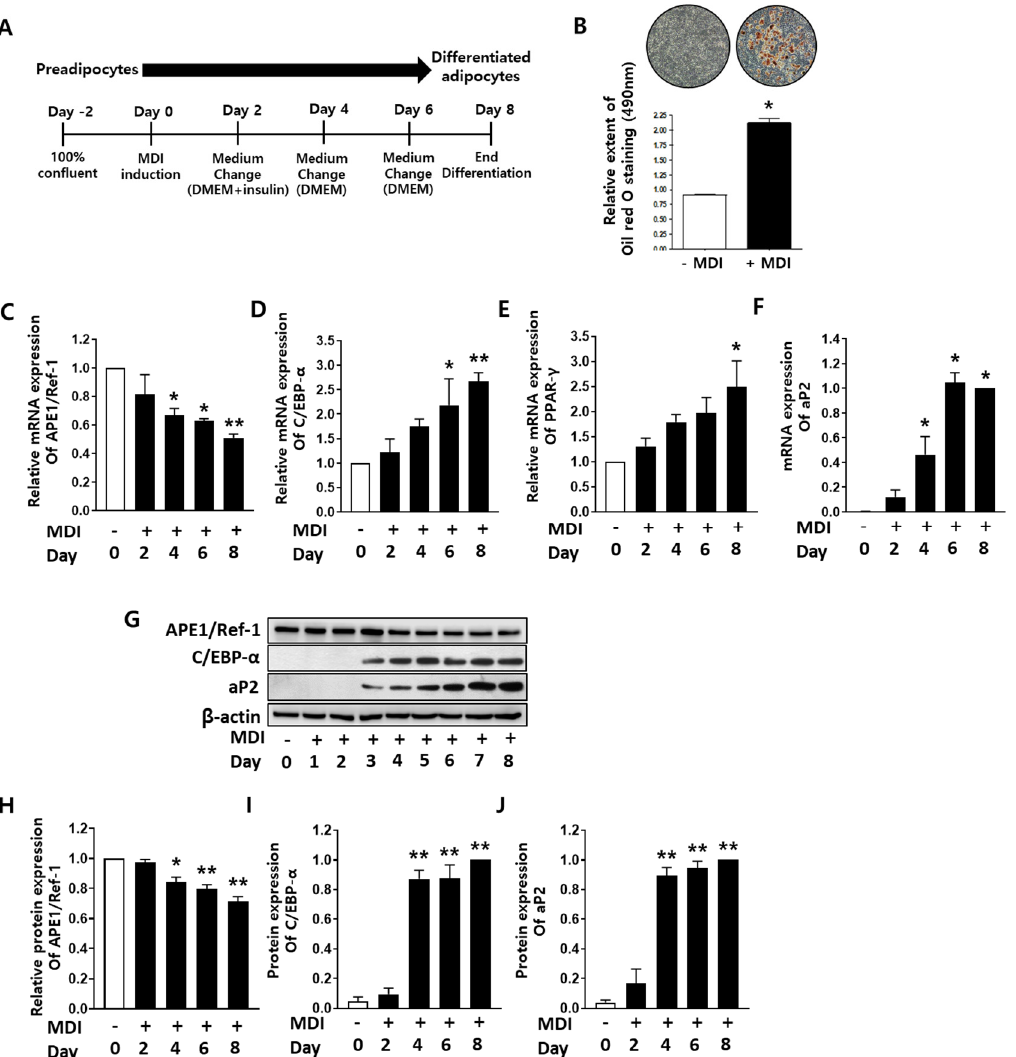
Figure 1. Changes in the expression of adipocyte differentiation markers and apurinic/apyrimidinic endonuclase1/redox factor-1 ( APE1/Ref-1 ) during adipocyte differentiation in 3T3-L1 cells. Adipocyte differentiation of 3T3-L1 cells was induced by incubation in MDI during the indicated days as described in Material and Methods. ( A ) Schematic protocol for preadipocyte differentiation of 3T3-L1 adipocytes. ( B ) Oil red O staining after adipocyte differentiation induction with MDI. In the microscopic image ( × 100 magnification), triglyceride lipid droplets stained with Oil Red O appear red along with a quantitative graph of lipid content obtained using spectrophotometry based on the absorbance at 490 nm. ( C ) A decrease in APE1/Ref-1 mRNA expression during adipocyte differentiation for the indicated times (0–8 days). ( D – F ) Changes in the mRNA expression of adipocyte differentiation markers C/EBP- α , PPAR- γ , and aP2 . ( G ) Representative Western blotting results of APE1/Ref-1, C/EBP- α , and aP2 proteins during adipocyte differentiation. ( H ) APE1/Ref-1 protein expression decreased during adipocyte differentiation, and ( I , J ) C/EBP- α and aP2 protein expression increased during adipocyte differentiation. The graph shows the average band intensity normalized to β -actin expression. mRNA expression of aP2 and protein expression of C/EBP- α and aP2 were determined by comparing with the relative maximum value in 8 days. All qRT-PCR and Western blotting experiments were replicated at least three times. The data represent mean ± SEM ( n = 3). * p < 0.05 and ** p < 0.01 indicate statistically significant differences compared with the basal level using the one-way ANOVA followed by Bonferroni’s multiple comparison test.